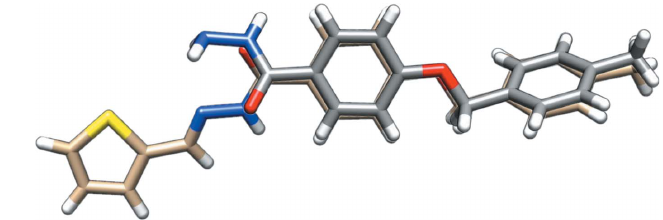
Figure 3 Overlay plot of molecules (I) and (II) to show the conformational